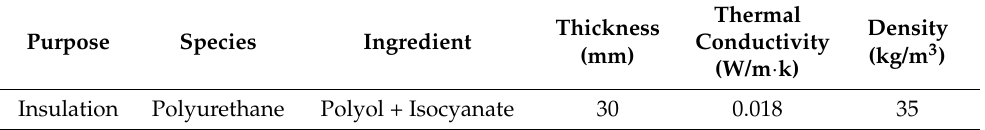
Table 3. Physical properties of the urethane board used in insulated gang